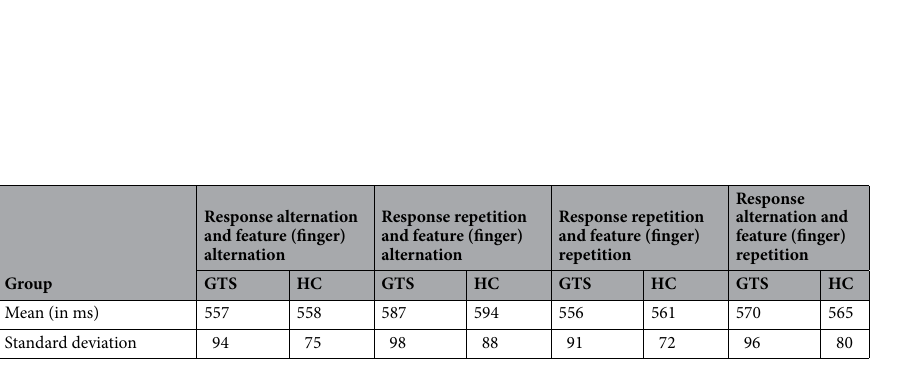
Table 3. Descriptive statistics (response times). Mean response times in milliseconds (ms) for each group and condition including respective standard